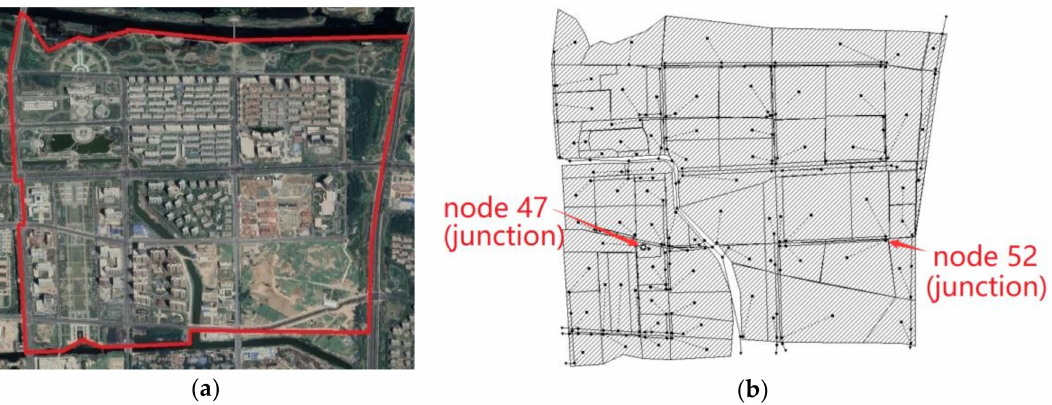
Figure 1. Situation in the study area: ( a ) Plan of the study area; ( b ) Drainage system in the base